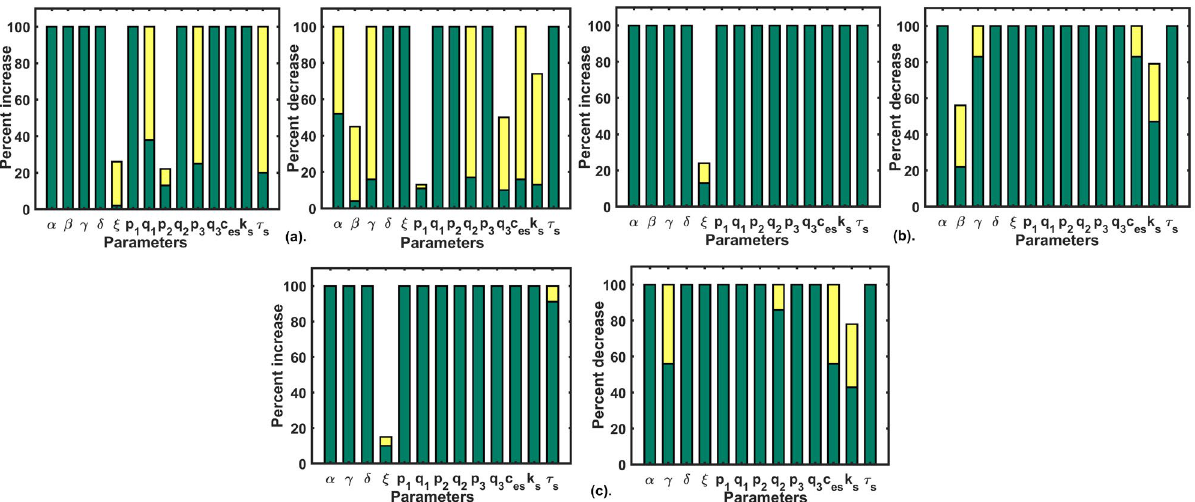
Figure 6. Parametric recalibration results: (a) the figure plot shows the single parameter variation results for Doxo 1; (b) the figure plot shows the single parameter variation results for Doxo 2; (c) the figure plot shows the double parameter variation results for Doxo 3 after reducing β (SOCE calcium influx rate) by 20%. The green bar shows the range for non-CRD and the yellow bar shows the range after CRD is obtained